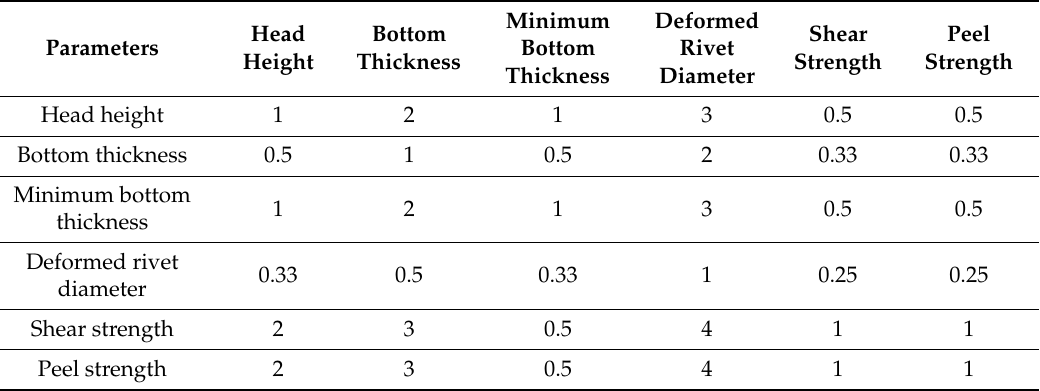
Table 5. Relative importance of the criteria.